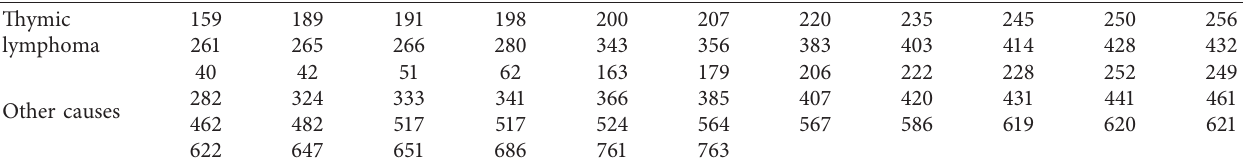
Table 1: The failure data of 61 male mice under radiation dose or 300r at age 5-6 weeks.